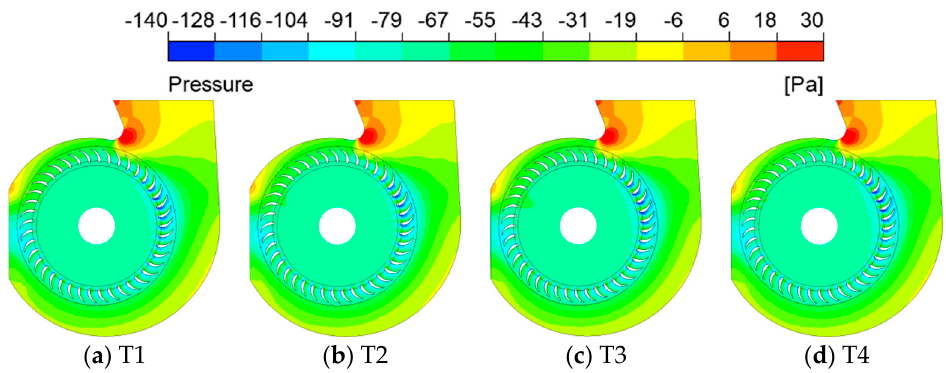
Figure 10. Distribution of static pressure on Z = 4 mm cross-section for the r = 11 mm model.